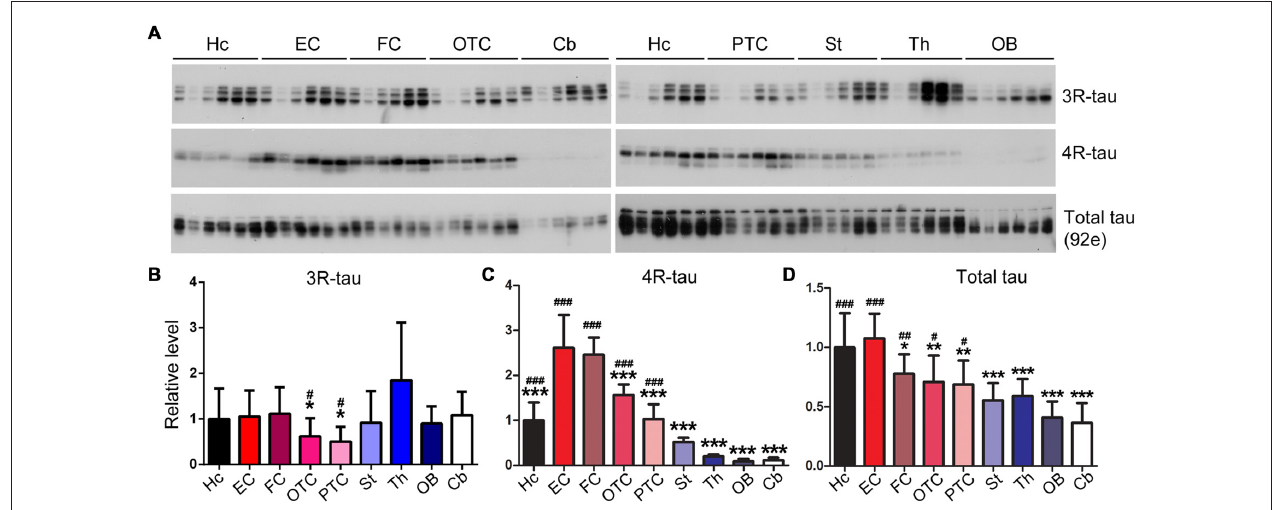
FIGURE 4 | Expression level of tau is different in different regions of the rat brain. Same amount of protein of nine brain regions was analyzed by Western blots developed with anti-3R-tau (RD3), anti-4R-tau (RD4) and anti-total tau (92e) (A) . Relative levels of 3R-tau (B) , 4R-tau (C) and total tau (D) were also expressed as mean ± SD, which represents matched observations of individual brain regions in six rats, and subjected to repeated measures one-way ANOVA followed by Tukey’s post hoc test (and the same for the figures hereafter). ∗ Indicates statistical significance when compared to the EC, the earliest cortical area that develops tau pathology in AD brain; # indicates statistical significance compared to the cerebellum, a brain area that is spared from tau pathology. ∗ , # P < 0.05; ∗∗ , ## P < 0.01; ∗∗∗ , ### P < 0.001. OB, olfactory bulb; FC, frontal cortex; PTC, parietal-temporal cortex; OTC, occipital-temporal cortex; EC, entorhinal cortex; Cb, cerebellum; St, striatum; Th, thalamus; Hc,